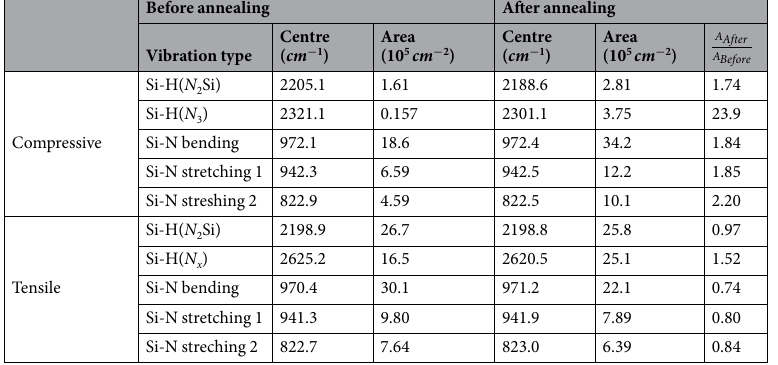
Table 2. Lorentzian fitting results for the compressive and tensile stress samples before and after the annealing